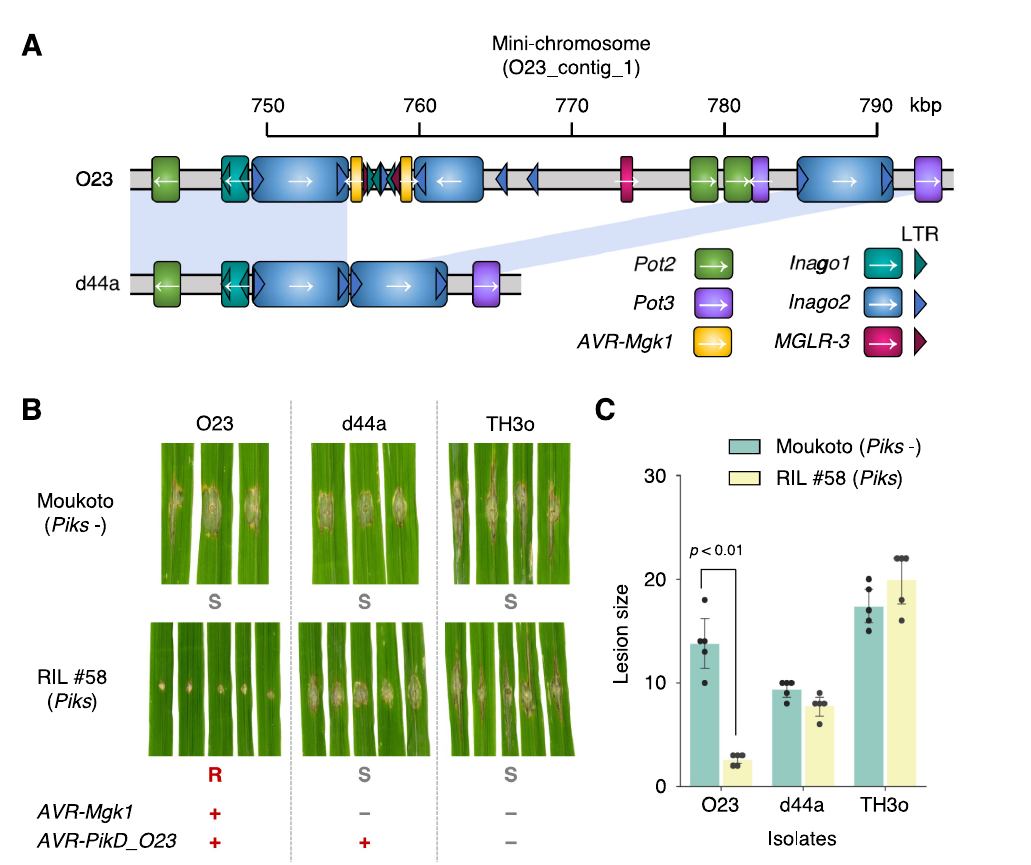
Fig 5. Inago2 retrotransposon repeat sequence-mediated deletion of AVR-Mgk1 re-establishes virulence. (A) Comparison of the genomic structures around the AVR-Mgk1 genes between M . oryzae isolates O23 and d44a; d44a is an F 1 progeny of TH3o × O23. d44a lost the 2 AVR-Mgk1 genes. Sequences of transposable elements around AVR-Mgk1 genes ( Pot2 , Pot3 , Inago1 , Inago2 , and MGLR-3 ) are indicated by color-coded rectangles. LTRs of retrotransposons are shown in triangles. (B) d44a is virulent against RIL #58 rice plants. We performed punch inoculation assays using O23, TH3o, and d44a on RIL #58 ( Piks ) plants. (C) Quantification of the lesion size in (B). Statistically significant differences are indicated ( p < 0.01, two-sided Welch’s t test). The data underlying Fig 5C can be found in S1 Data . LTR, long terminal repeat; RIL, recombinant inbred